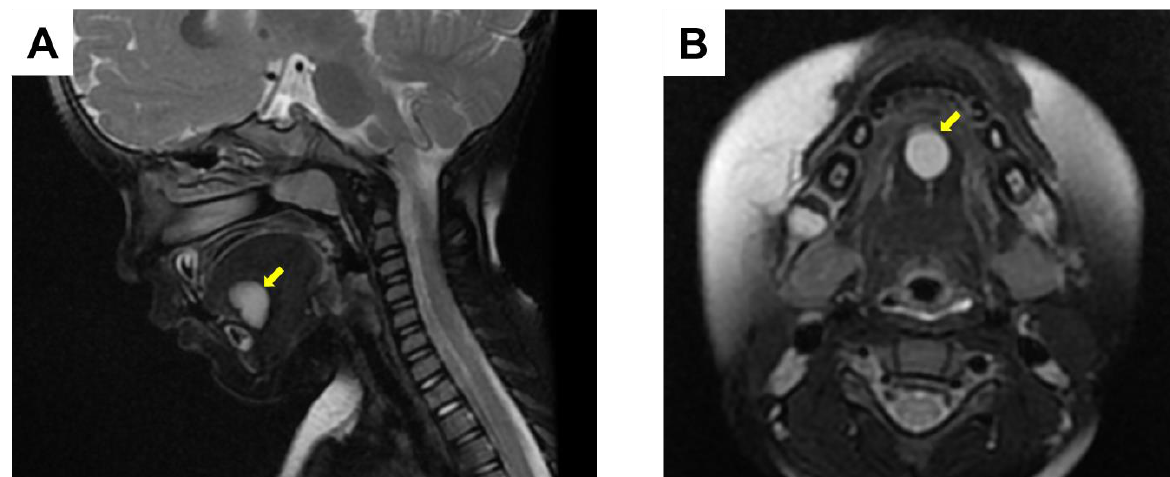
Figure 2. MRI results at time of initial visit. Arrow indicates cystic lesion. ( A ) Axial T2-weighted image. ( B ) Coronal T2-weighted image.